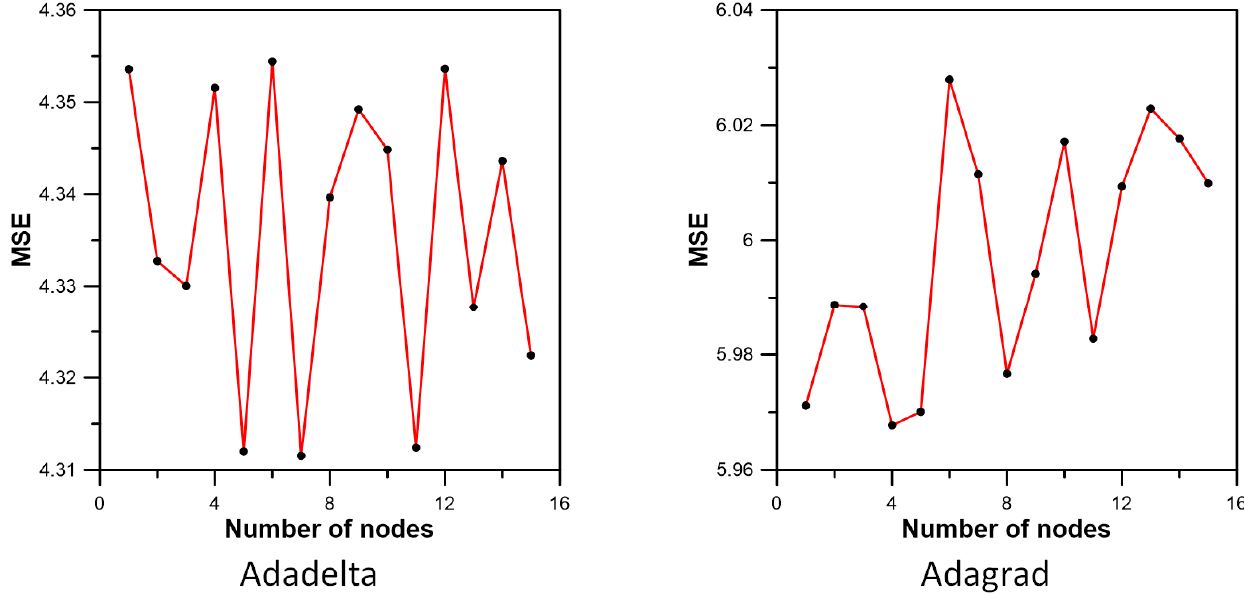
Figure 15. Results according to the number of hidden layers (Adadelta and Adagrad).